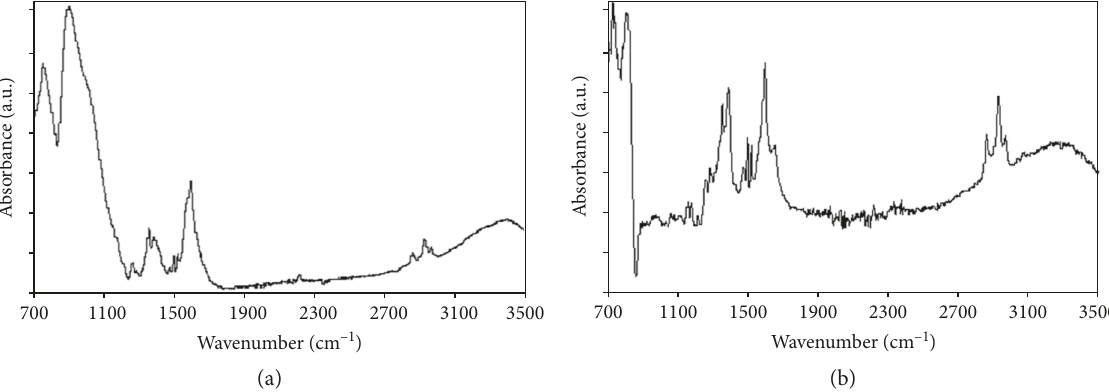
Figure 4: (a) ATR-FTIR spectrum of CL1 dye showing sharp phenyl and thiophene ring modes at 1517, 1491, 1375, and 1256cm − 1 , whilst the C – N stretching mode of triarylamine appeared at 1348cm − 1 . (b) ATR-FTIR spectrum of CL1 dye adsorbed on TiO υ (COO − ) and υ (COO − ) stretching modes of carboxylate linker groups at 1590 and 1382 cm − 1 , respectively, whilst the C ≡ N stretch asym sym frequency was unchanged at 2209 cm − 1